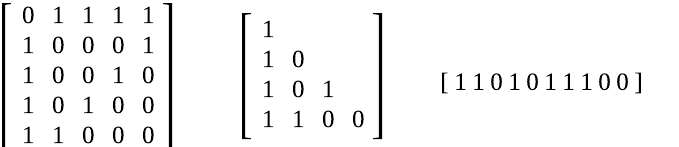
Fig 12. Matrix form, triangular matrix form and string form of graphlet 18. These forms correspond to graphlet 18 as it is shown in Fig 5. The string form is not the lexicographically smallest possible for this